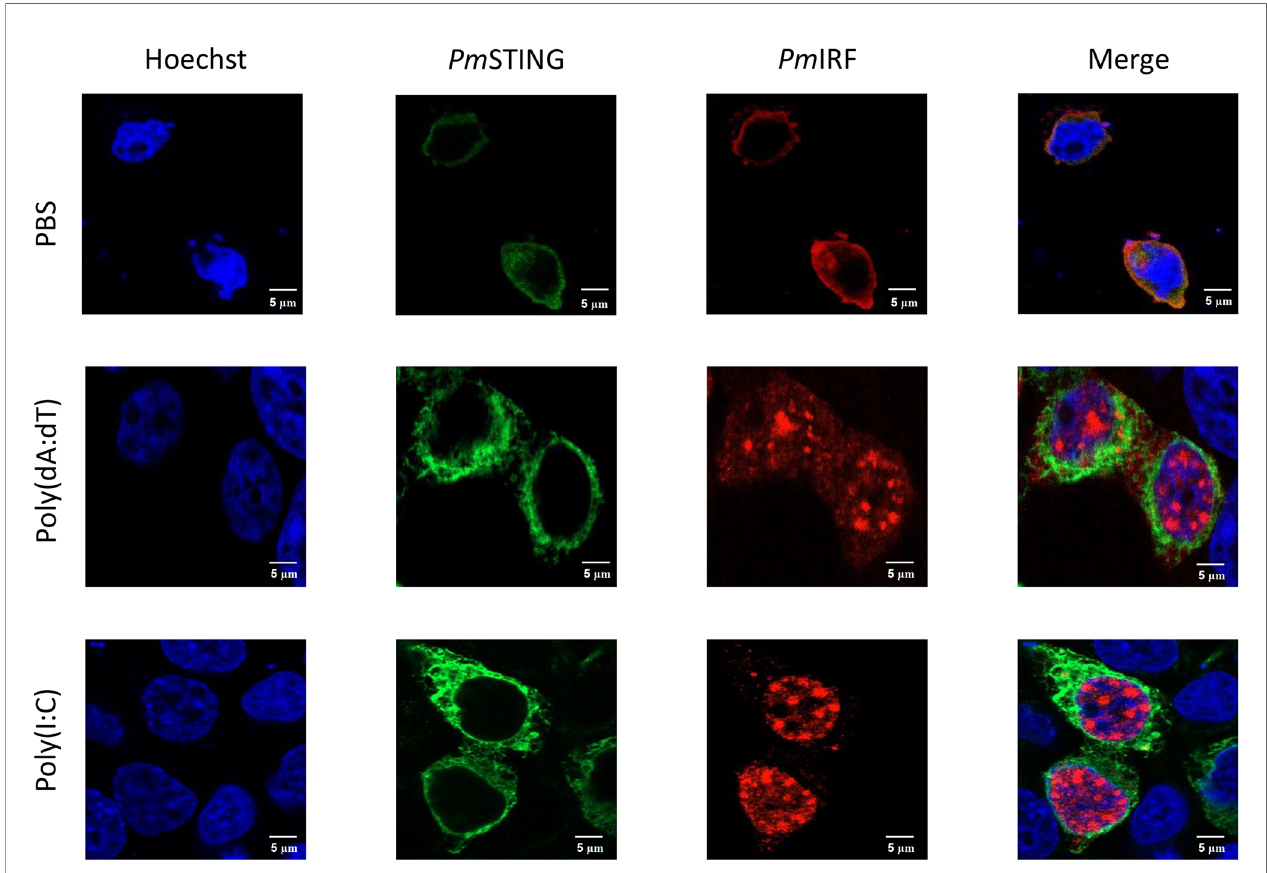
FIGURE 5 | Subcellular localization of Pm IRF and Pm STING in HEK293T cells. Cells were co-transfected with Flag-tagged Pm IRF and Myc-tagged Pm STING expression plasmids for 24 h, then stimulated with 1 m g/ml poly(dA:dT) or HMW poly(I:C) for 6 h before labeling with an Alexa Fluor 568-conjugated anti-Flag antibody (red) and Alexa Fluor 488-conjugated anti-Myc antibody (green). Nuclei were stained with Hoechst 33342 (blue). Scale bar, 5 m m. Fluorescence was detected by laser scanning confocal microscopy (63× magni fi